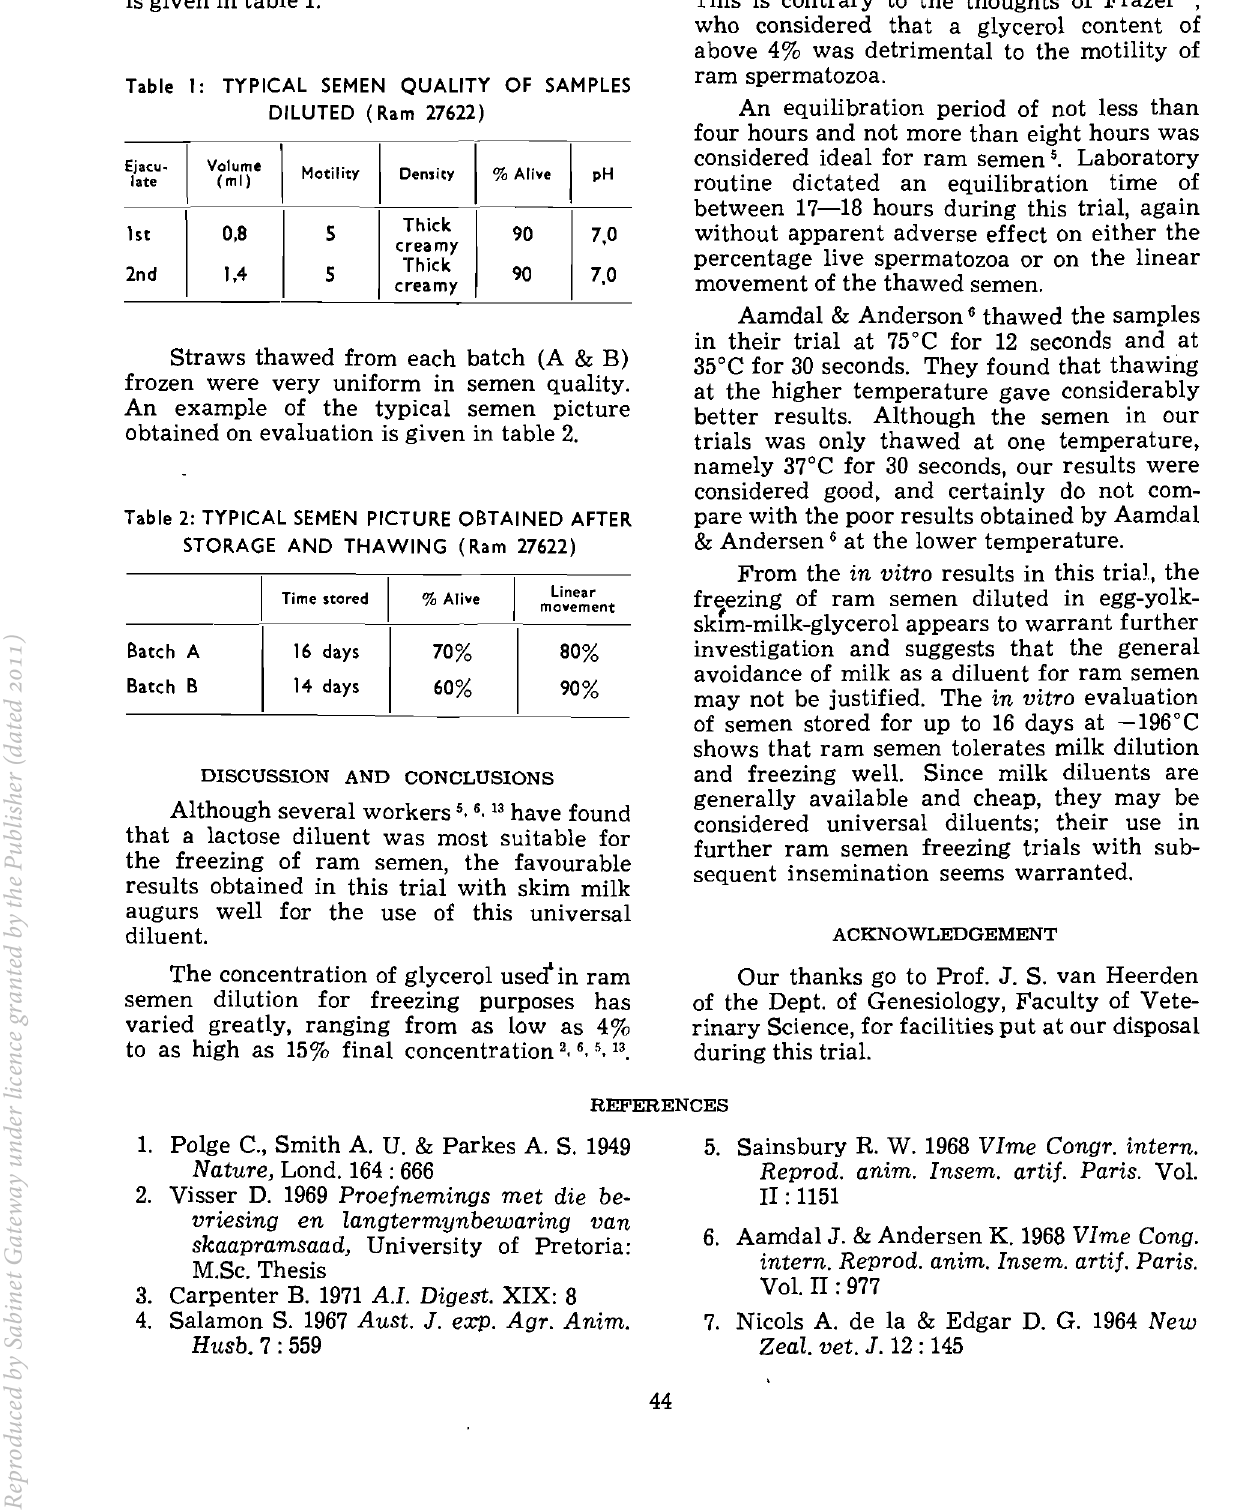
Table 1: TYPICAL SEMEN QUALITY OF SAMPLES DILUTED (Ram 27622)